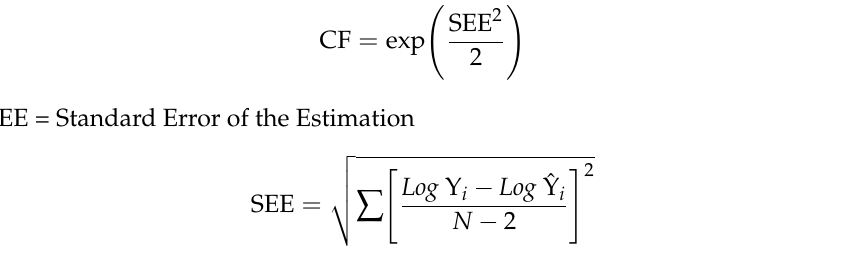
Table 3. Characteristic of the destructive tree samples of the 30 trees.